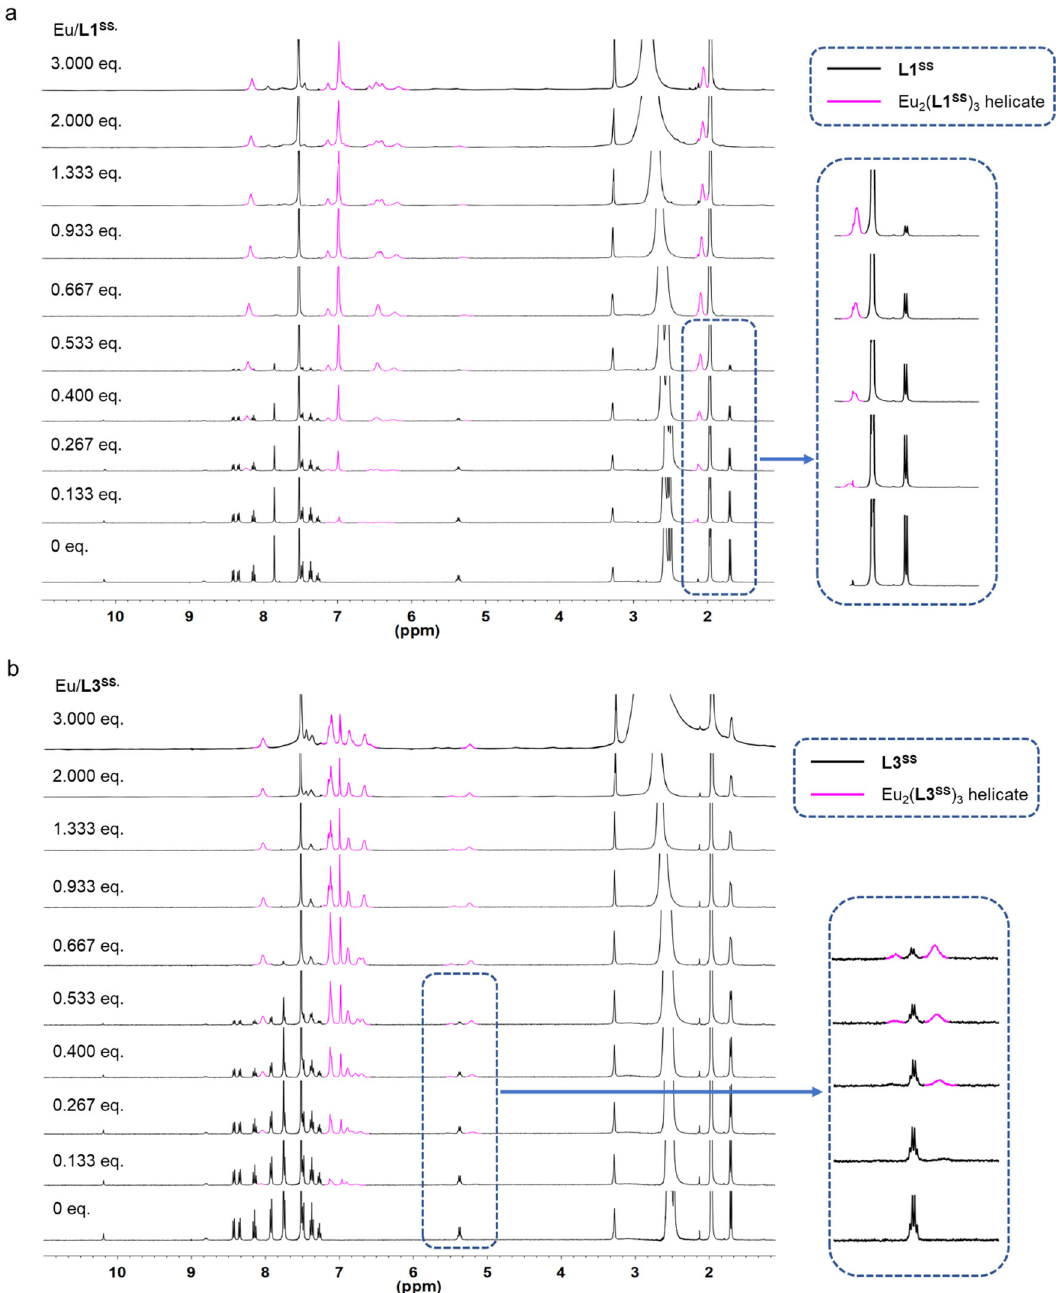
Fig. 2 1 H NMR titrations of L1 and L3 with Eu(OTf) 3 . a Variation in 1 H NMR spectra of L1 SS (1.09 × 10 − 3 M in 50:5:45, v/v/v of CDCl 3 /CD 3 OD/CD 3 CN) with Eu(OTf) 3 (0.108 M in CD 3 OD) at 298 K. When Eu/ L1 SS = 0.667 eq., all the ligand signals disappeared which con fi rmed the metal to ligand ratio is 2 – 3. b Variation in 1 H NMR spectra of L3 SS (8.80 × 10 − 4 M in 50:5:45, v/v/v of CDCl 3 /CD 3 OD/CD 3 CN) with Eu(OTf) 3 (0.090 M in CD 3 OD) at 298 K (bottom). When Eu/ L3 SS = 0.667 eq., all the ligand signals disappeared which con fi rmed the metal to ligand ratio is 2 –